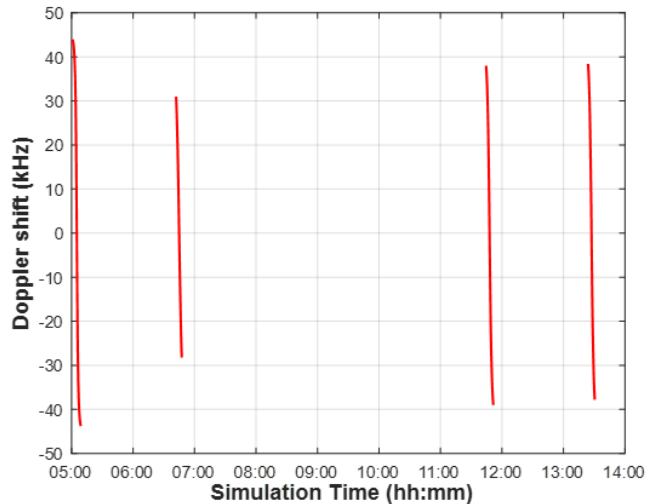
Figure 8. Doppler shift between the reference position (latitude 36.35080 ◦ N, longitude 127.30122 ◦ E) and a satellite receiver over a simulation time based on the actual satellite orbit data on 22 February